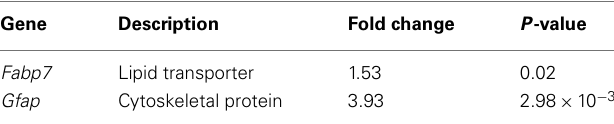
Table 1 | Genes differentially expressed in regions of induced young adult neurogenesis that are associated with and expressed by developmental radial